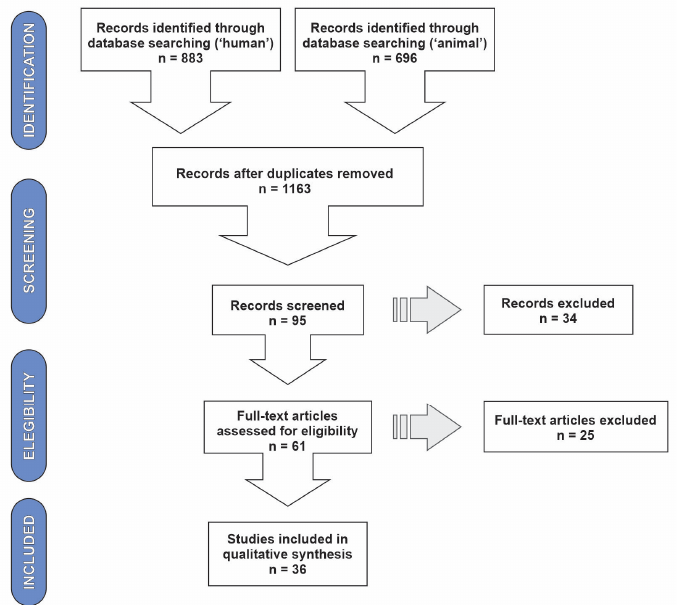
Figure 1. Representation of literature review methodological process elaborated according to PRISMA